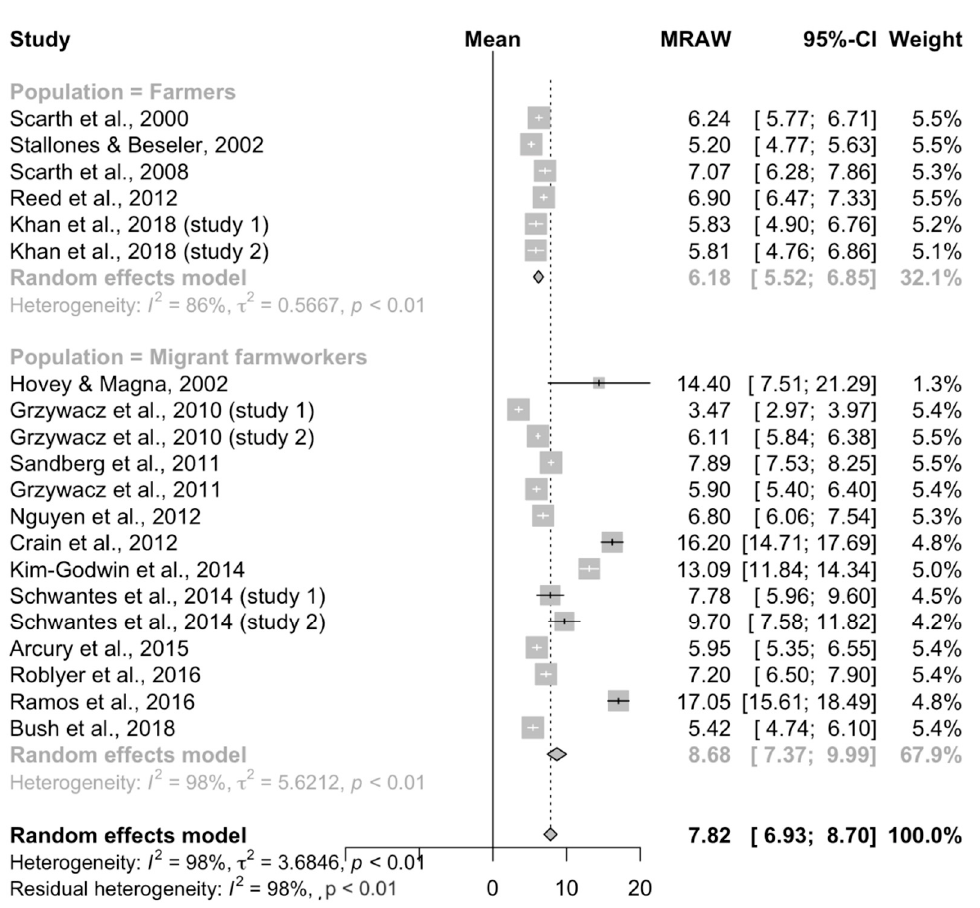
Figure 5. Results of the subgroup meta-analysis of the 20 studies conducted in the United States reporting a continuous outcome (raw mean score, MRAW) using the CES-D / DR scale to measure depression in farming populations.